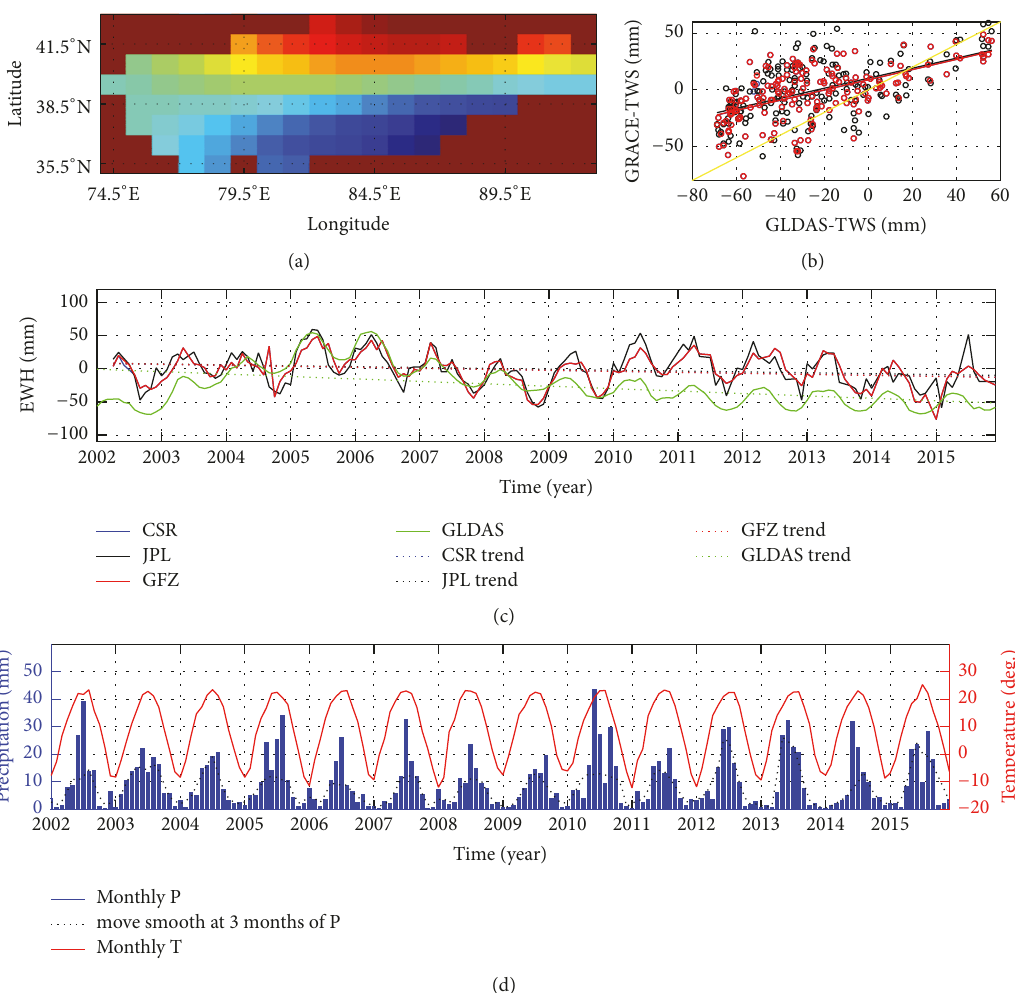
Figure 3: The distribution of water resource factors. (a) The distribution of averaged TWS; (b) correlation relationship between GRACE and GLDAS; (c) time series of monthly TWS of GRACE and GLDAS; and (d) time series of monthly precipitation and temperature. “EWH” stands for equivalent water